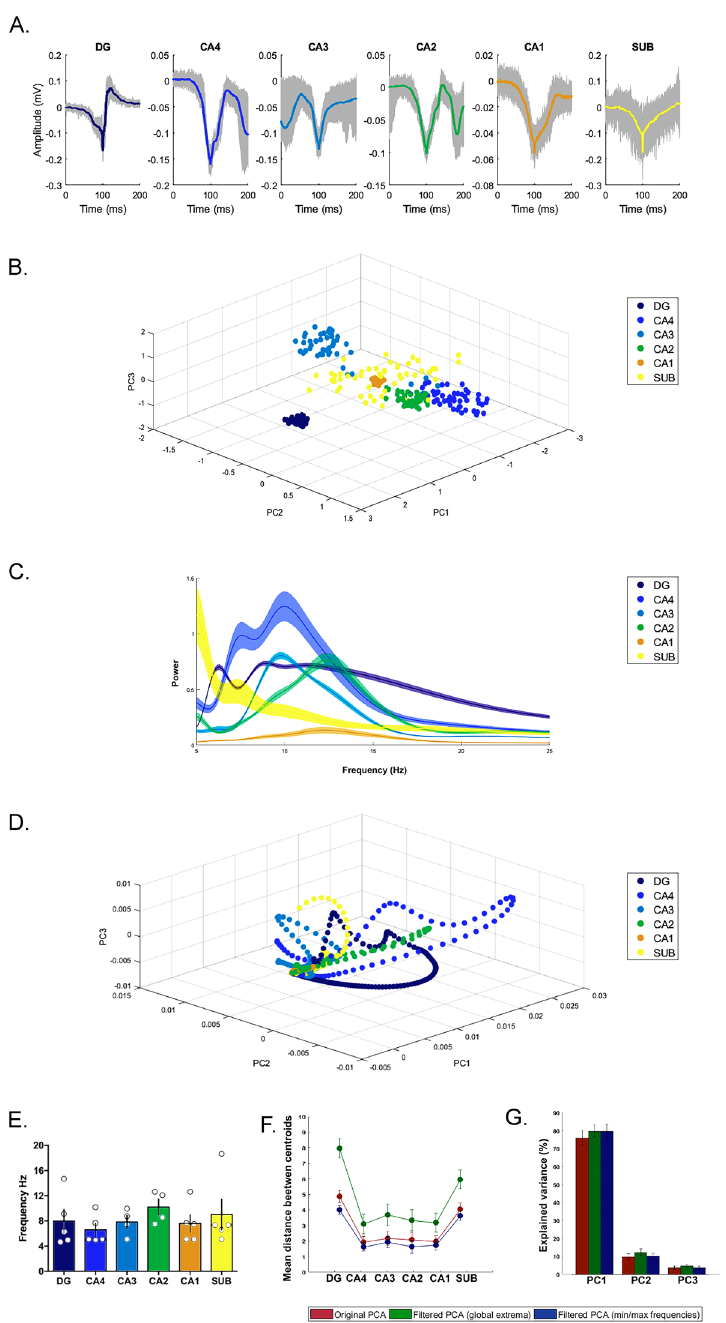
Figure 5. Electrophysiological signal analysis. Electrophysiological analysis of one illustrative patient (case one) is showed in ( A – D ). Analysis of the other four patients also selected in this study are found in the supplementary information. ( A ) Averaged waveform of epileptiform patterns in each hippocampal subfield was obtained using the spike sorting-like procedure. The waveform in color represents the average of trial recordings, with 95% confidence intervals (gray background). ( B ) Principal component analysis showing different clusters among hippocampal subfields. ( C ) Power frequency of the different hippocampal subfields; note that each subfield exhibited different power-frequency ranges. The average power frequency is represented by the continuous line in color with their respective confidence interval of α = 0.05. ( D ) Principal component analysis applied on the frequency domain; observe the different trajectories and critical points in each hippocampal subfield. ( E – G ) shows analysis of all five tissue samples. ( E ) Maximal frequencies displayed by the epileptiform patterns in different hippocampal subfield. Bar graphs represent the means and standard deviation. ( F ) Cluster centroid distances in each hippocampal subfield between original PCA (red circles) and PCA after filtering recordings using the critical points in each trajectory (green circles) and with minimal and maximal frequencies (blue circles). The distance centroid is represented by the confidence interval mean and its standard deviation. ( G ) Percentage of explained variances of PCA with filtered and unfiltered data. Bar graphs represent the mean and standard